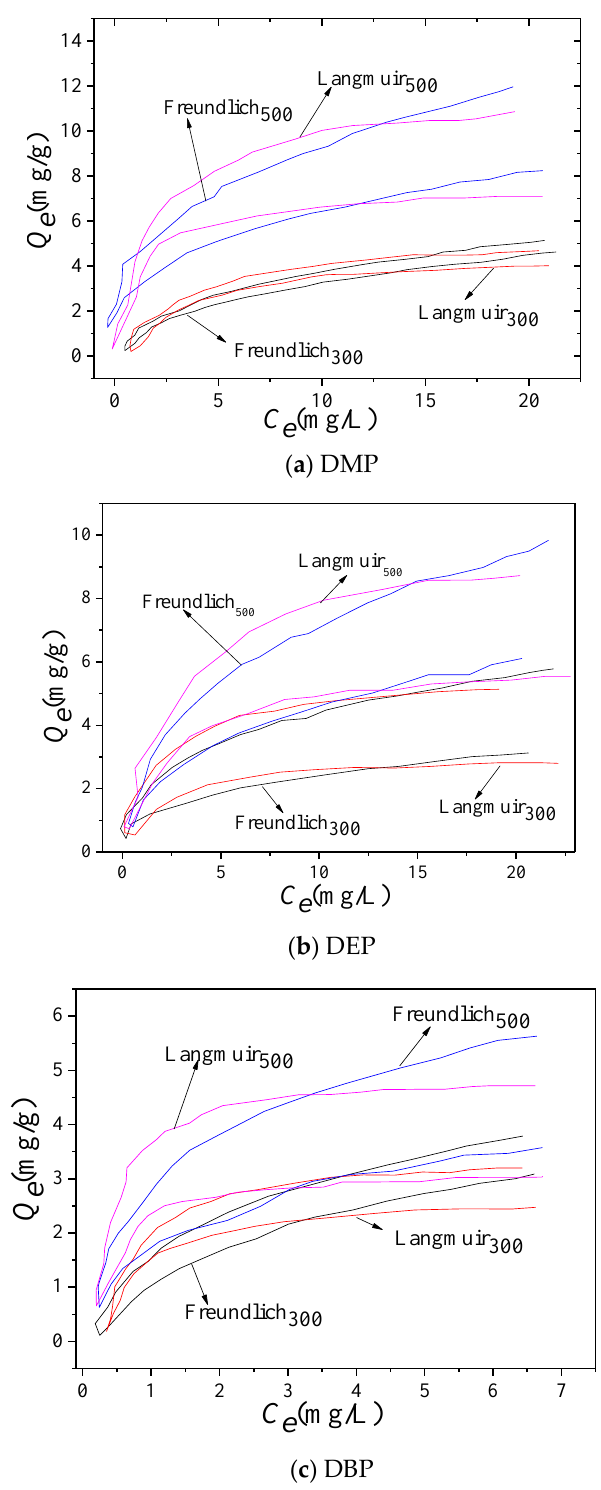
Figure 7. The adsorption curves of DMP, DEP, and DBP were fitted by Freundlich model and Langmuir model, respectively; ( a ) DMP;( b ) DEP;( c ) DBP.